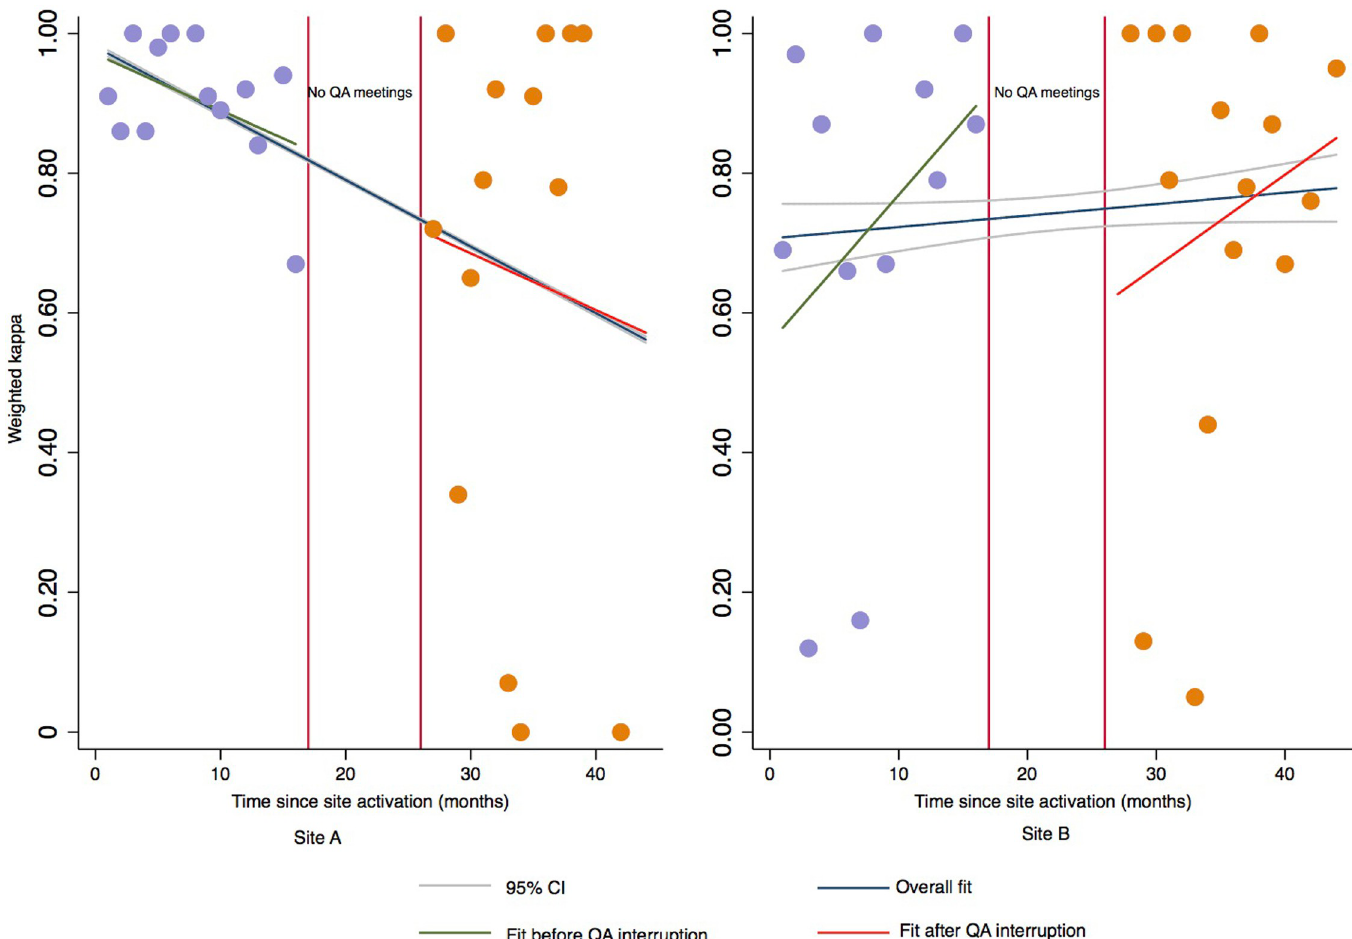
Fig 2. Sensitivity analysis comparing kappa estimates from linear piecewise regression models with splines and linear regression models without splines. The period of QA interruption is indicated by red vertical lines. Average change in weighted kappa estimates with each additional month a site is fully operational before (Fit before QA interruption) and after (Fit after QA interruption) QA interruption are provided as well as the overall change in weighted kappa estimate ignoring the QA interruption (Overall fit) with confidence intervals (95% CI). In Site A, there was a decrease in weighted kappa estimates both before and after the interruptions in QA meetings. In contrast, there was increasing trend in weighted kappa estimates for Site B, both before and after the QA interruption. Results from the more parsimonious linear regression models (overall fit) were not significantly different from the models with